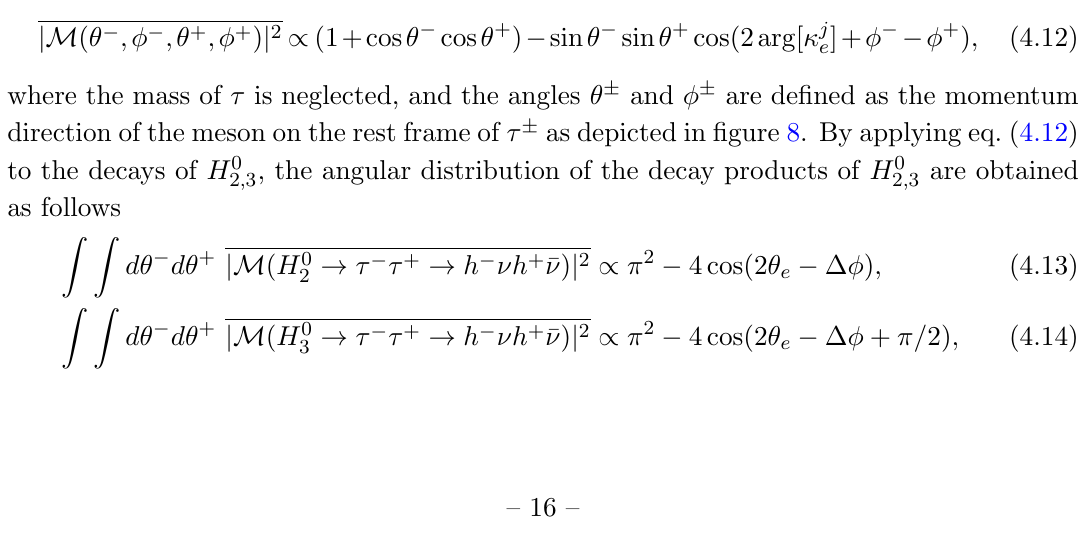
Figure 8 . Schematic pictures for the angles (cid:18) (cid:6) and (cid:30) (cid:6) de(cid:12)ned on the rest frame of (cid:28) (cid:6) . The z axis is de(cid:12)ned along with the direction of (cid:28) (cid:0) on the rest frame of H 0 is given by O (100) fb [112] which is roughly two orders of magnitude larger than our cross section. Thus, we can safely avoid the constraint from the current LHC